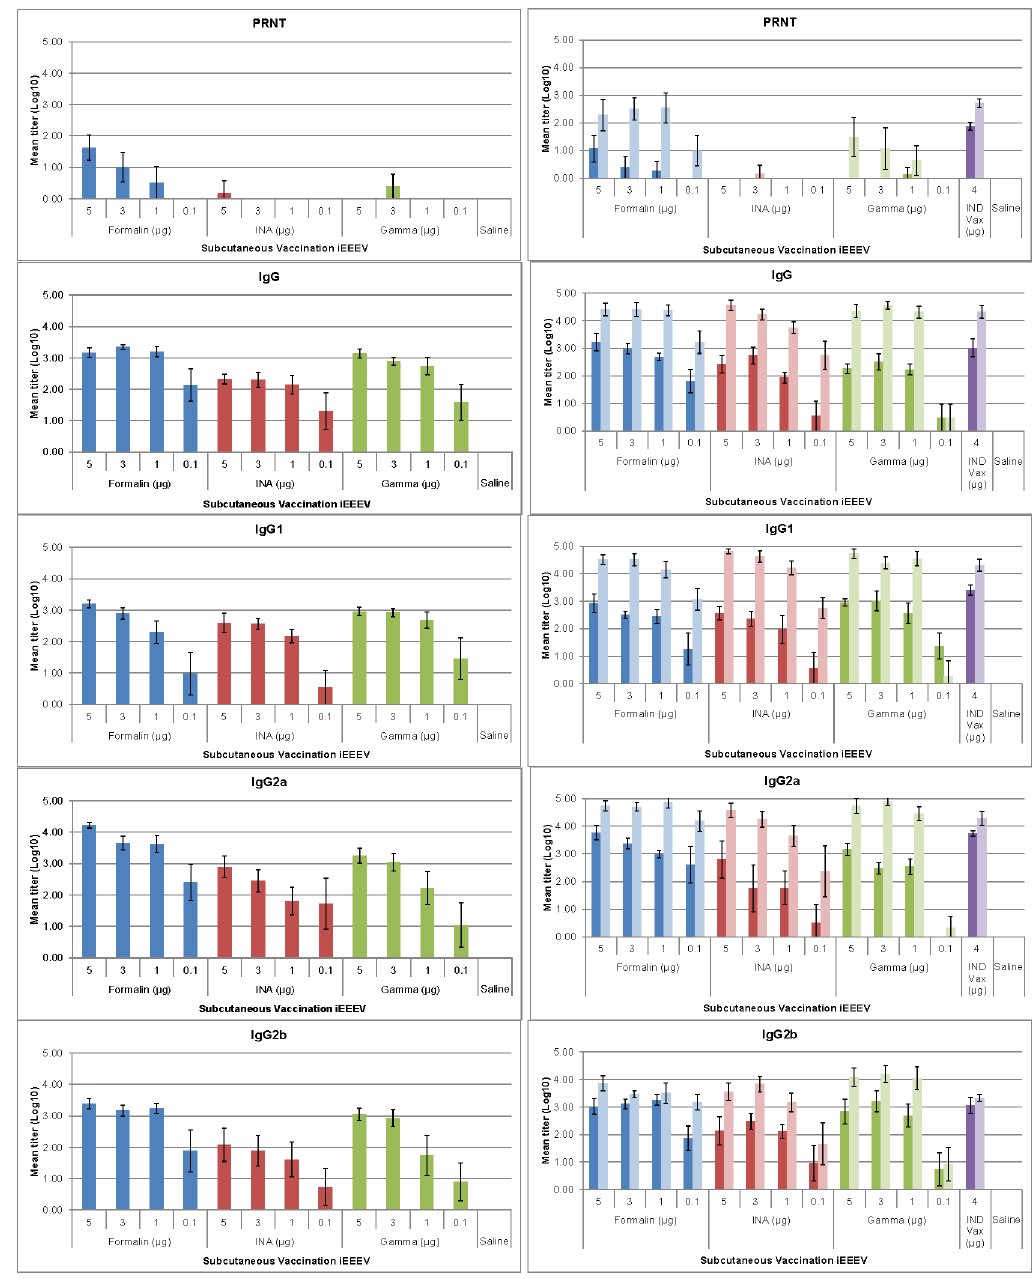
Figure 6. Serum antibody responses in mice vaccinated subcutaneously with iEEEV vaccine candidates. Groups of BALB/c mice (n=10) were vaccinated once (graphs on left) or twice (graphs on right) with one of three iEEEV vaccine candidates (formalin-inactivated, INA-inactivated, or gamma irradiated) at doses ranging from 5–0.1 m g by the SC route. Serum was collected 21 d after each vaccination. Neutralizing antibody responses were determined by PRNT and serum antibody levels were determined by ELISA. In all graphs, dark bars represent the mean group titer 21 d after the first vaccination (n=10); light bars represent the mean group titer 21 d after the second vaccination (n=10). Standard error bars represent 2 times the SE of the mean (SE=SDxsqrt(n)). doi:10.1371/journal.pone.0104708.g006 impinger (AGI) (Ace Glass, Vineland, NJ). AGI samples were average group weights the day of exposure. The presented dose titrated by standard plaque assay on Vero cell monolayers [26]. was then calculated by multiplying the estimated total volume (V t ) Back titration of challenge virus preparations were determined by of experimental atmosphere inhaled by each animal (V t = V m x standard plaque assay using Vero cells. length of exposure) by the empirically determined exposure concentration (C e ) (‘presented dose’= C e x V t ). Exposure concen- tration, expressed in plaque-forming units (PFU)/L, was deter- mined by isokinetic sampling of the chamber with an all-glass